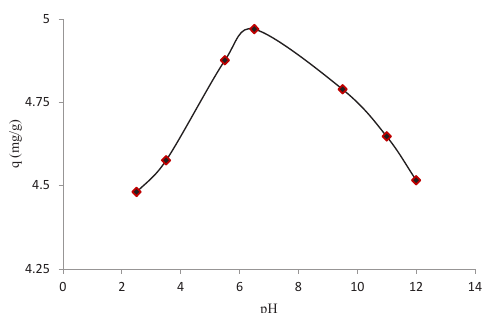
Fig.2:EffectofpHontheadsorptionofHg(II)ontoFe 3 O 4 –Polyrhodanine Fig. 2: Effect of pH on the adsorption of Hg (II) onto Fe3O4 –Polyrhodanine